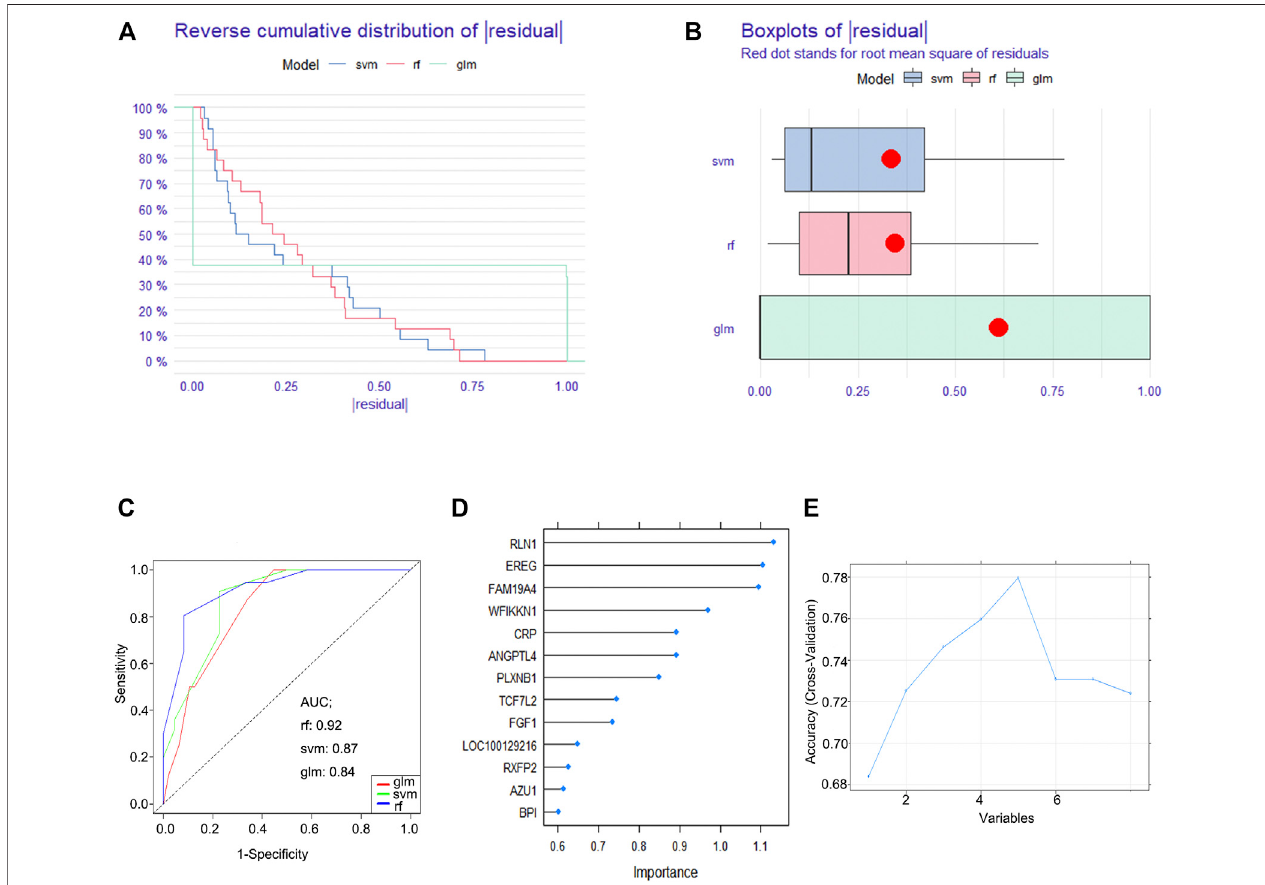
FIGURE 3 | Construction of a diagnostic immune-related gene signature. (A) Cumulative distribution of | residual | in RF, GLM, and SVM models. (B) Boxplots of | residual | in RF, GLM, and SVM models. (C) ROC curve and AUC value of RF, GLM, and SVM models. (D) The importance of explanatory variables ranked by the RF model. (E) Cross curve showing the accuracy of the RF